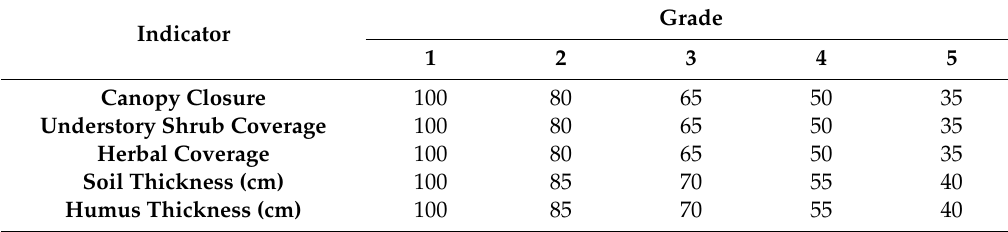
Table 3. Scores of di ff erent grades of the quantitative